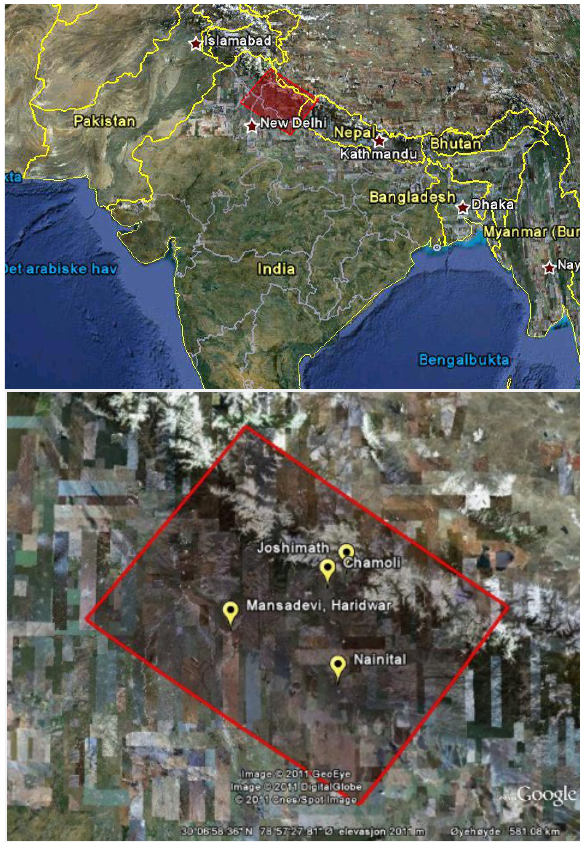
Figure 1: Location of target areas. Background data: GoogleEarth.